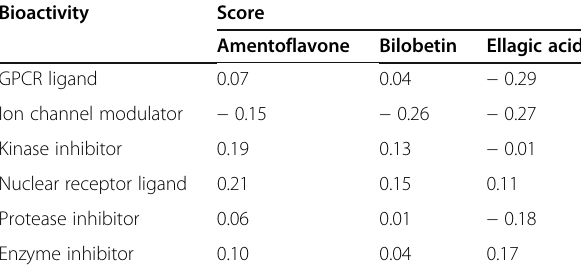
Table 7 Predicted biological activities of best three ligands Bioactivity